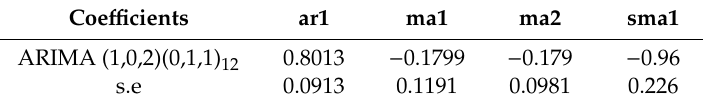
Table 1. Coe ffi cient estimations of ARIMA (1,0,2) (0,1,1) 12.